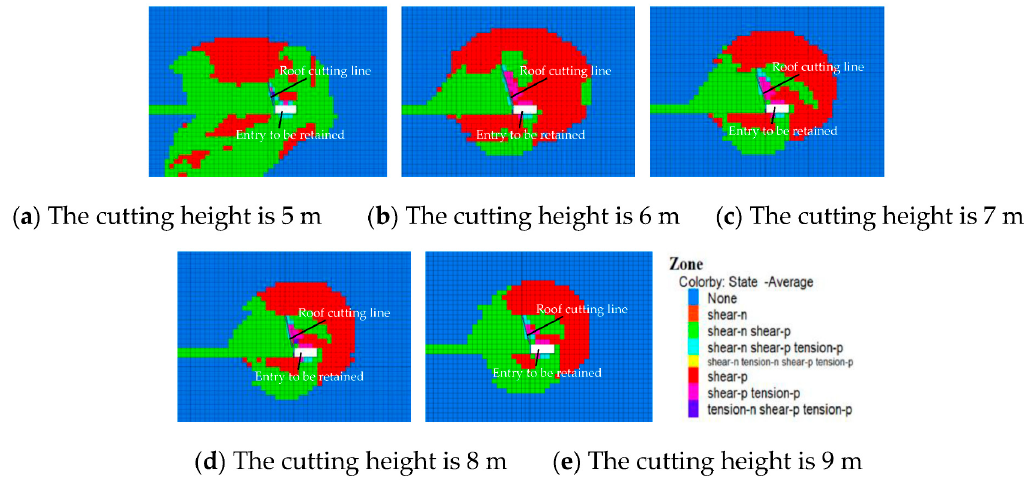
Figure 10. Plastic zone of roadway surrounding rock under different cutting